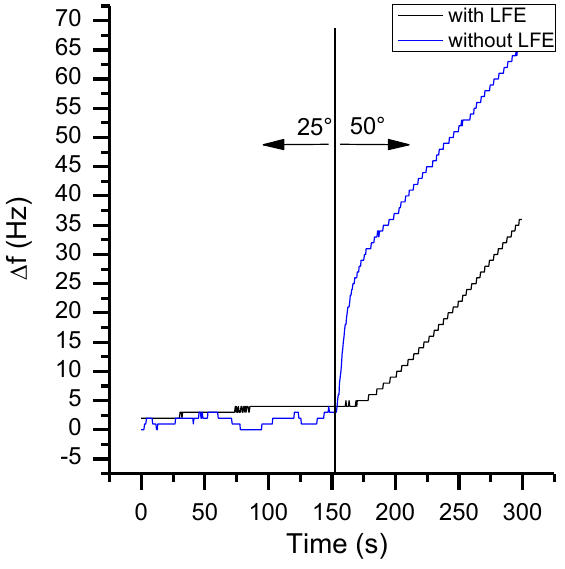
Figure 16. Frequency response to an environmental change of the temperature from 25 °C to 50